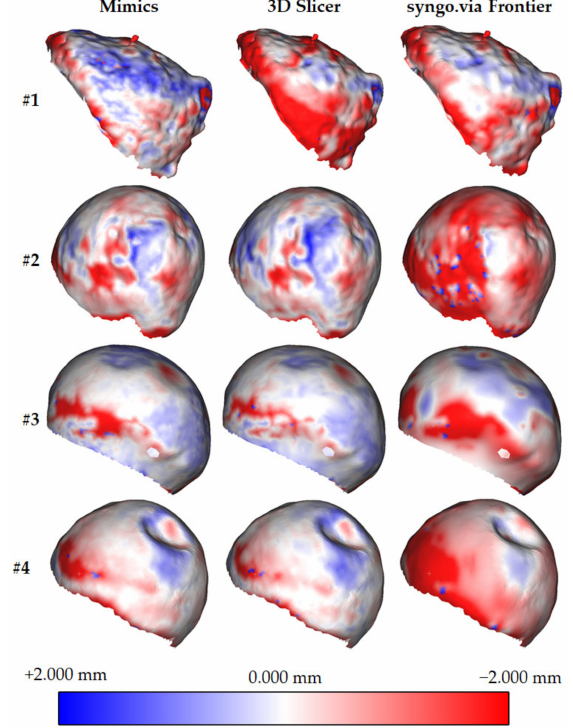
Figure 4. Signed Euclidean distance between the reference ( G_D ) and test ( G_A , G_B , and G_C ) geometries for patients #1, #2, #3, and #4. The deviation is represented in the reference geometry. Red: